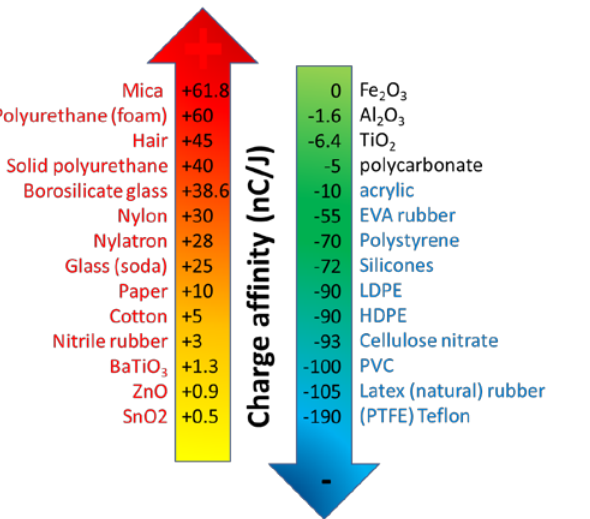
Figure 2. List of tribopositive and tribonegative materials for application in TENGs